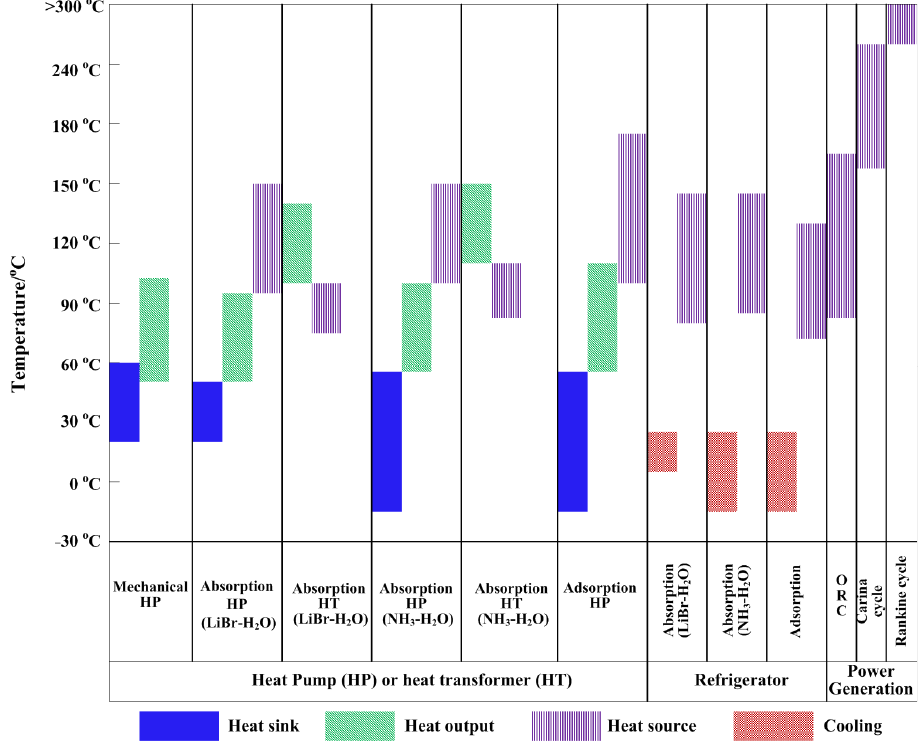
Figure 1. Typical applicable temperature ranges of different conversion technologies of waste heat [31]. heat